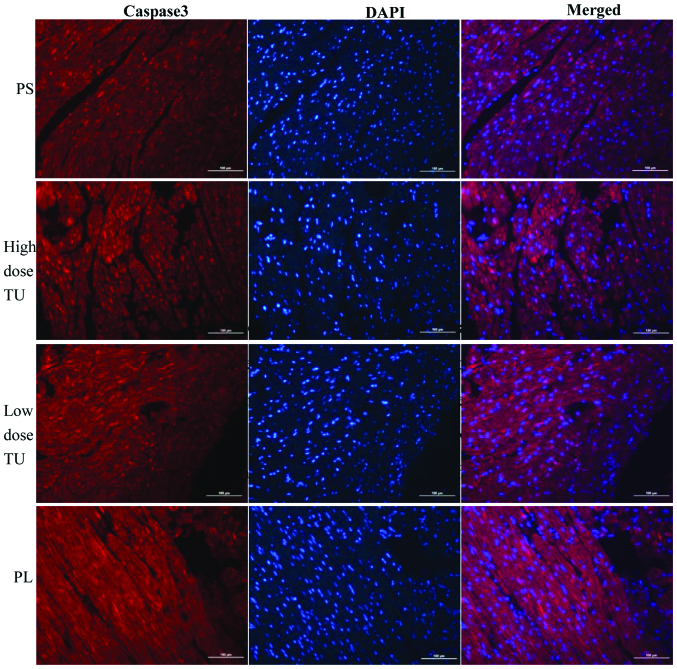
Expression of caspase-3 in each group. Bar, 100 μm. Sample size, n=5. Caspase-3 was mainly expressed in the myocardial cell cytoplasm and nucleus. The fluorescent expression of caspase-3 in the PL group was higher than that in the PS group (P<0.05). However, treatment with TU led to a significant decrease in caspase-3 expression (P<0.05). TU, testosterone; PS, pseudosurgery; PL, placebo.